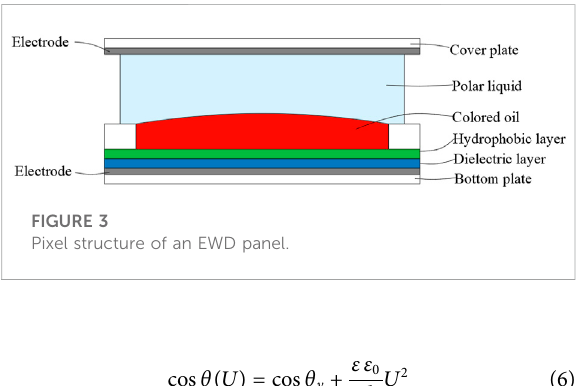
FIGURE 3 Pixel structure of an EWD